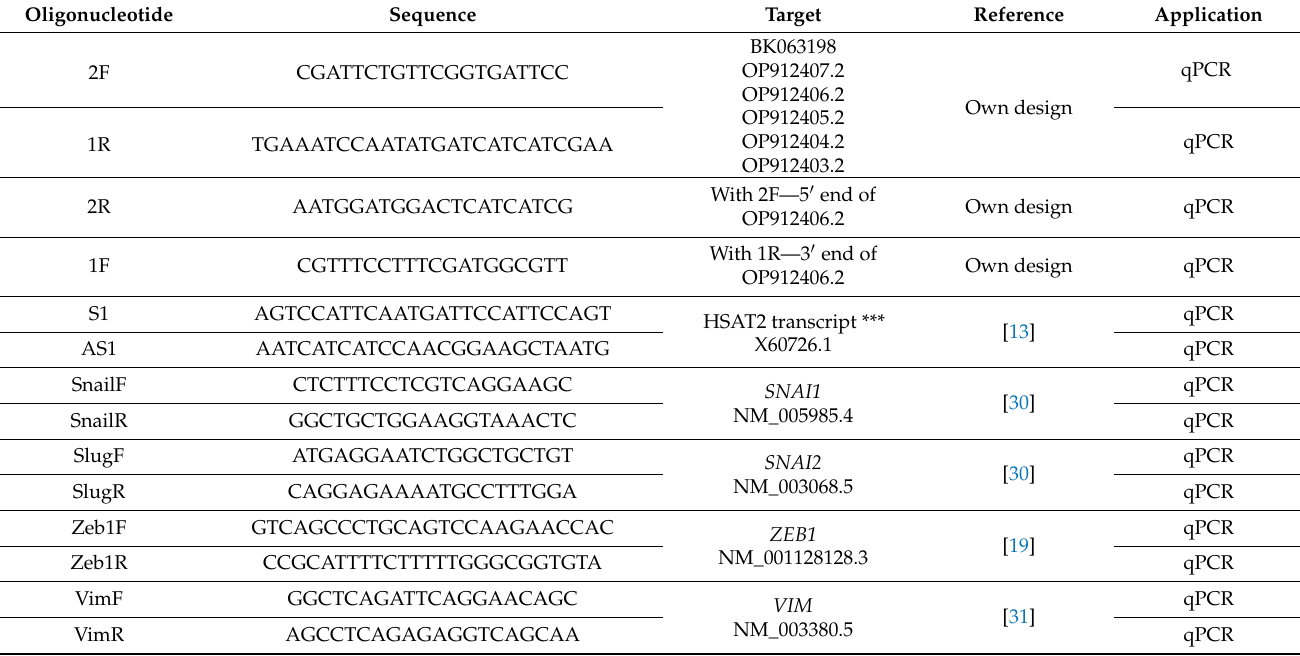
Table 2. Oligonucleotides used in the